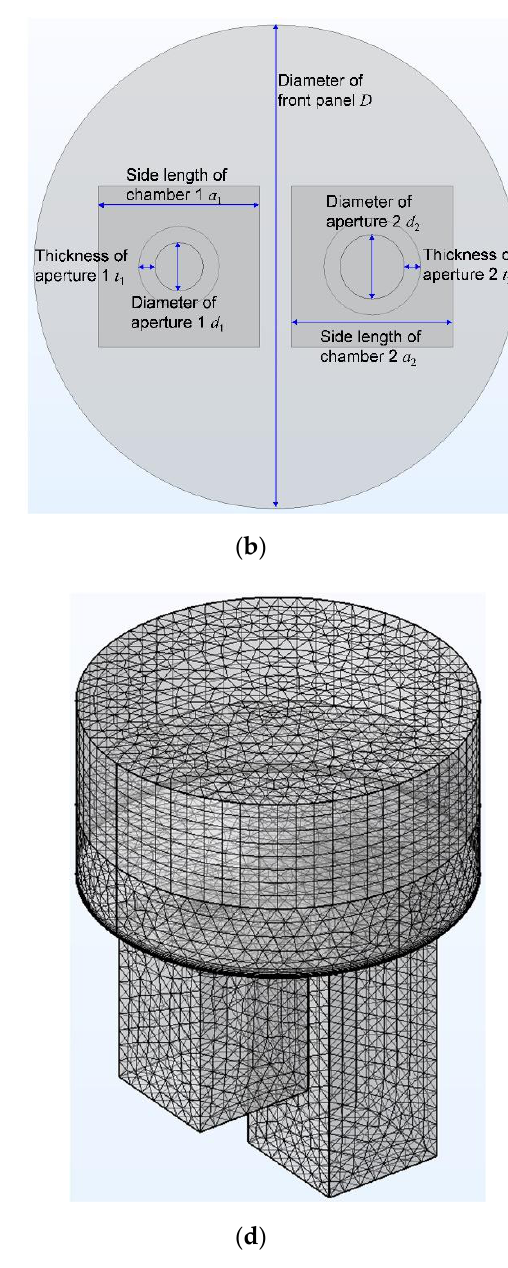
Figure 2. A 3-dimensional finite element simulation model for the double resonators. ( a ) 3D structure of the whole model; ( b ) The vertical view of model with the relevant parameters; ( c ) The front view of model with the relevant parameters; ( d ) The finite element simulation model with the gridded mesh.